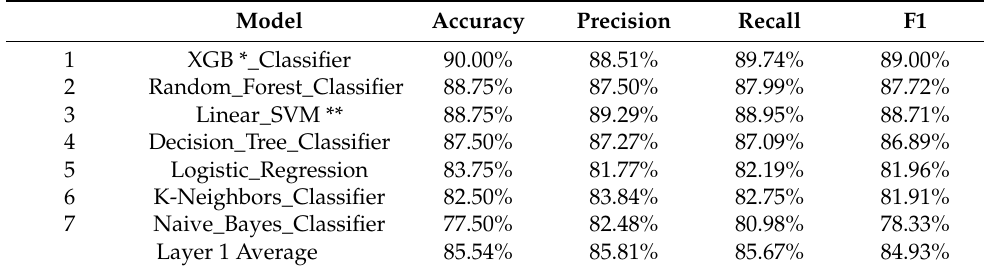
Table 4. Layer 1—Accuracy. Table 4. Layer 1 — Accuracy.